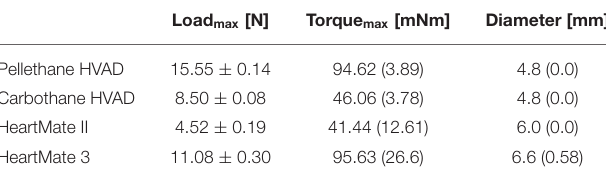
TABLE 1 | Summary of the mechanical features of the analyzed